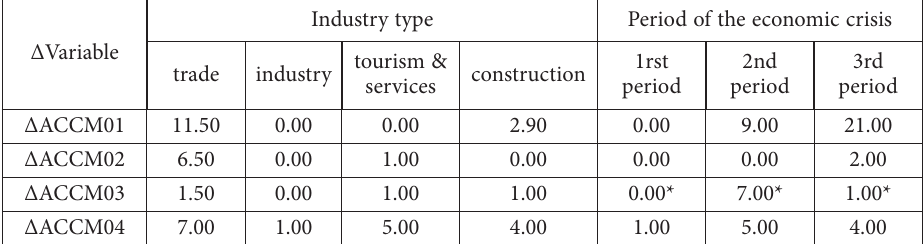
Table 6. Results from industry type and merger